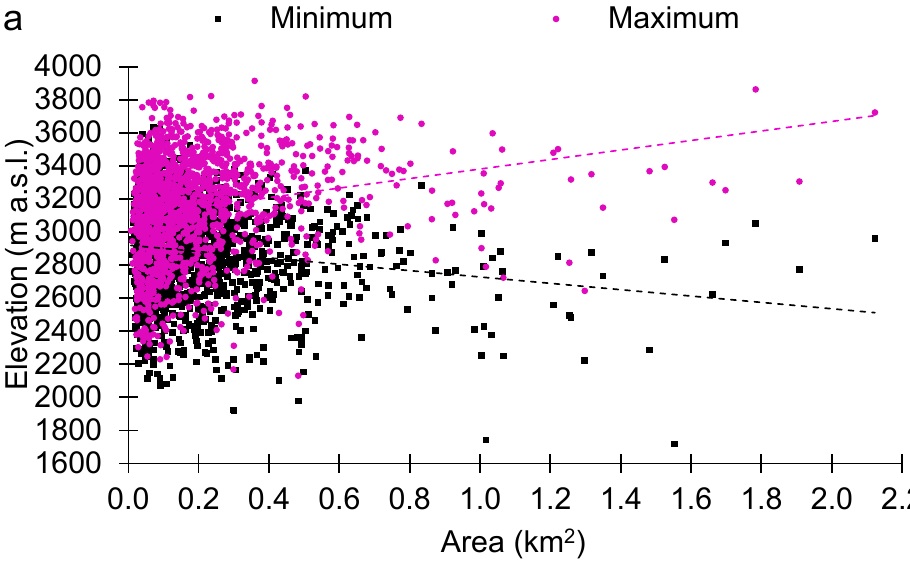
Figure 4. Color-coded map of active and relict rock glaciers for the Greater Caucasus. The average minimum elevation of all Caucasus rock glaciers was 2282 ± 87 m a.s.l.,